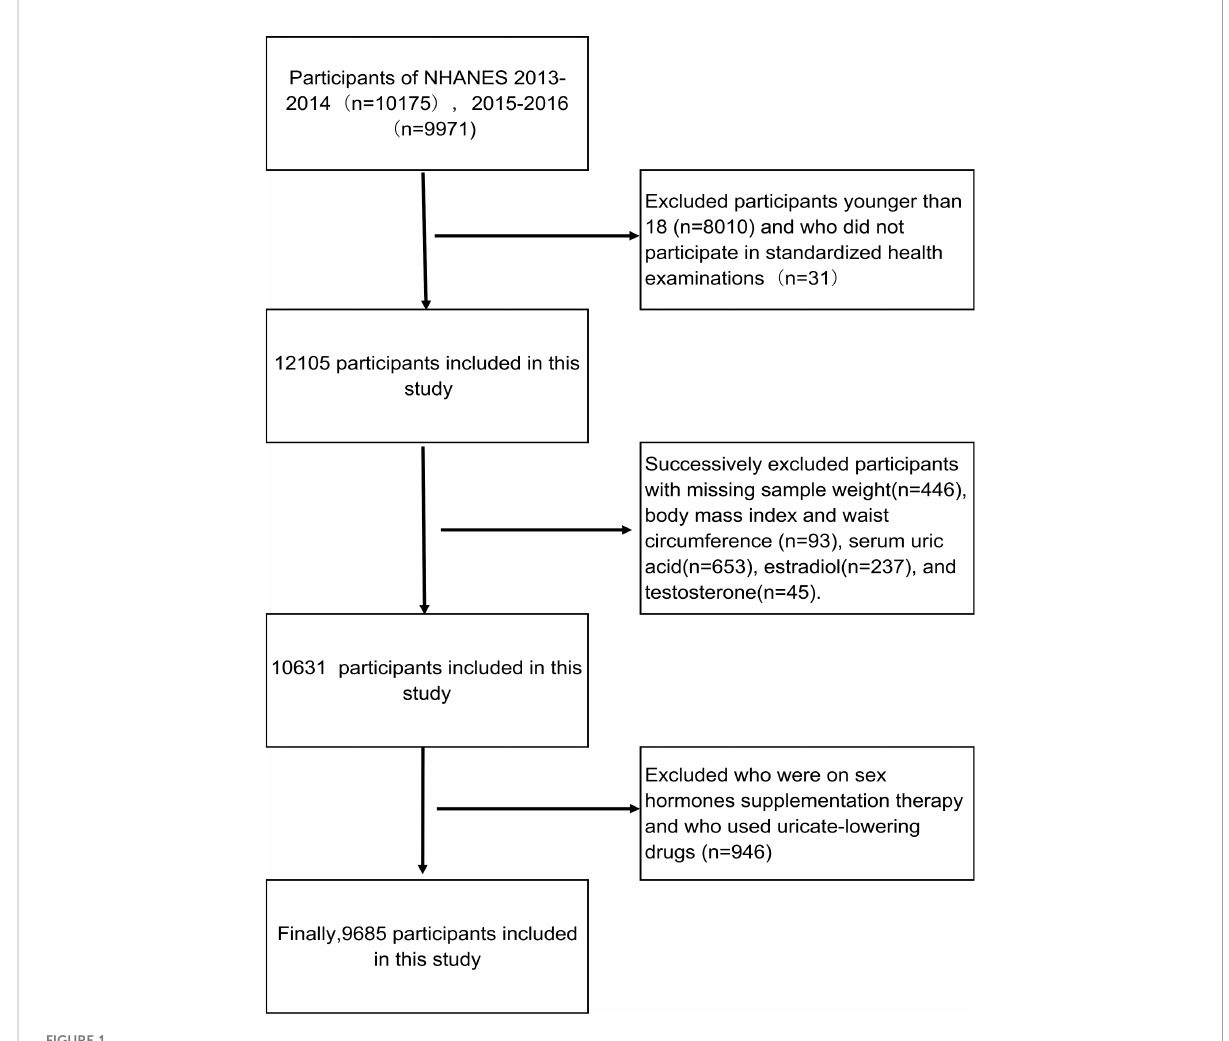
FIGURE 1 Flow chart of the screening process for the selection of eligible